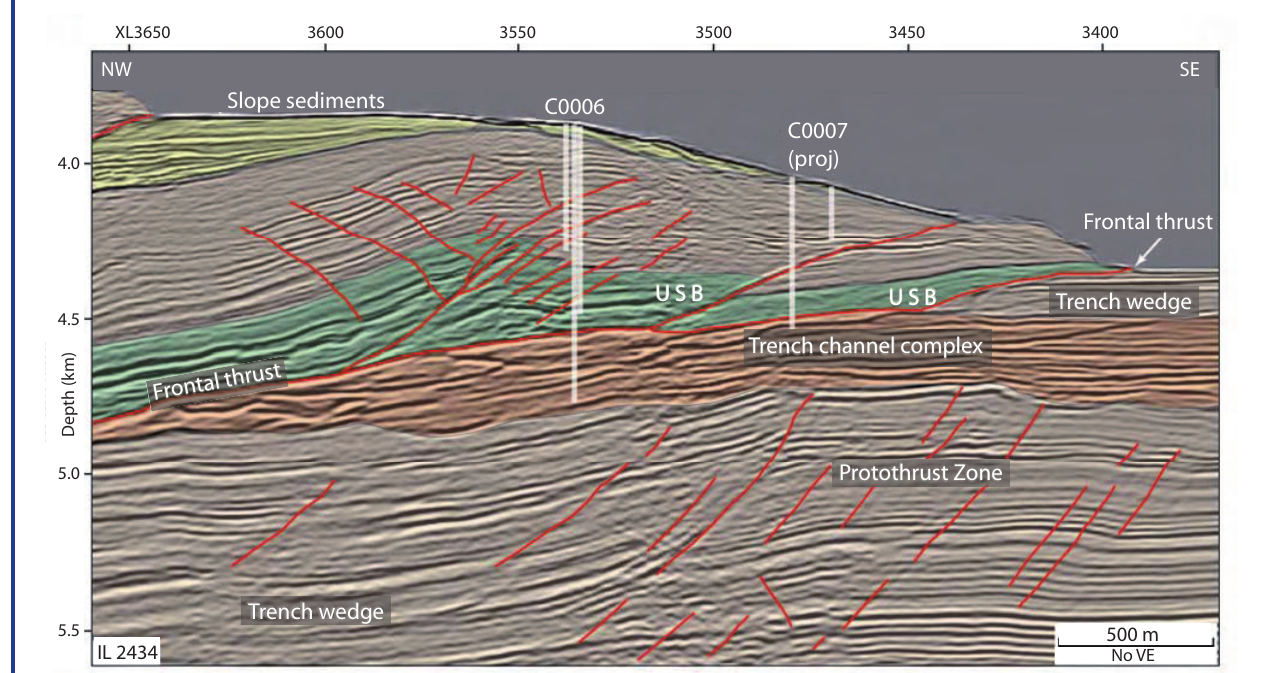
Figure 3. Inline seismic section for the frontal thrust region, Sites C0006 and C0007. Reproduced from Moore et al. (2009).